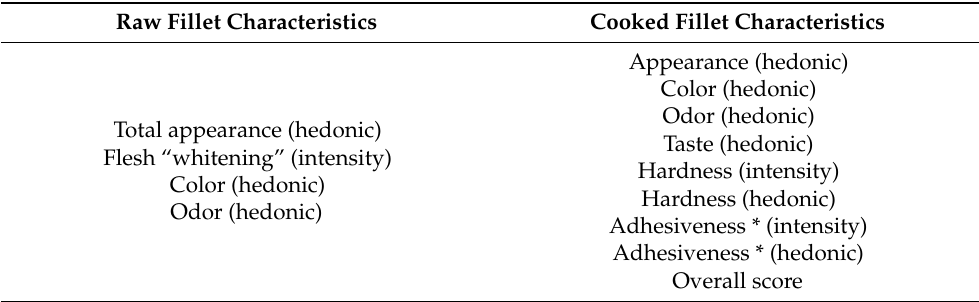
Table 1. Selected sensorial modalities [9-point intensity (1—lowest intensity; 9—highest intensity) and/or hedonic (1—dislike extremely; 9—like extremely)] for raw and cooked fish